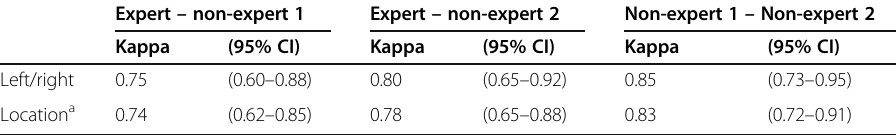
Table 4 Kappa values for inter-observer agreement between the expert and non-expert readers Expert – non-expert 1 Expert – non-expert